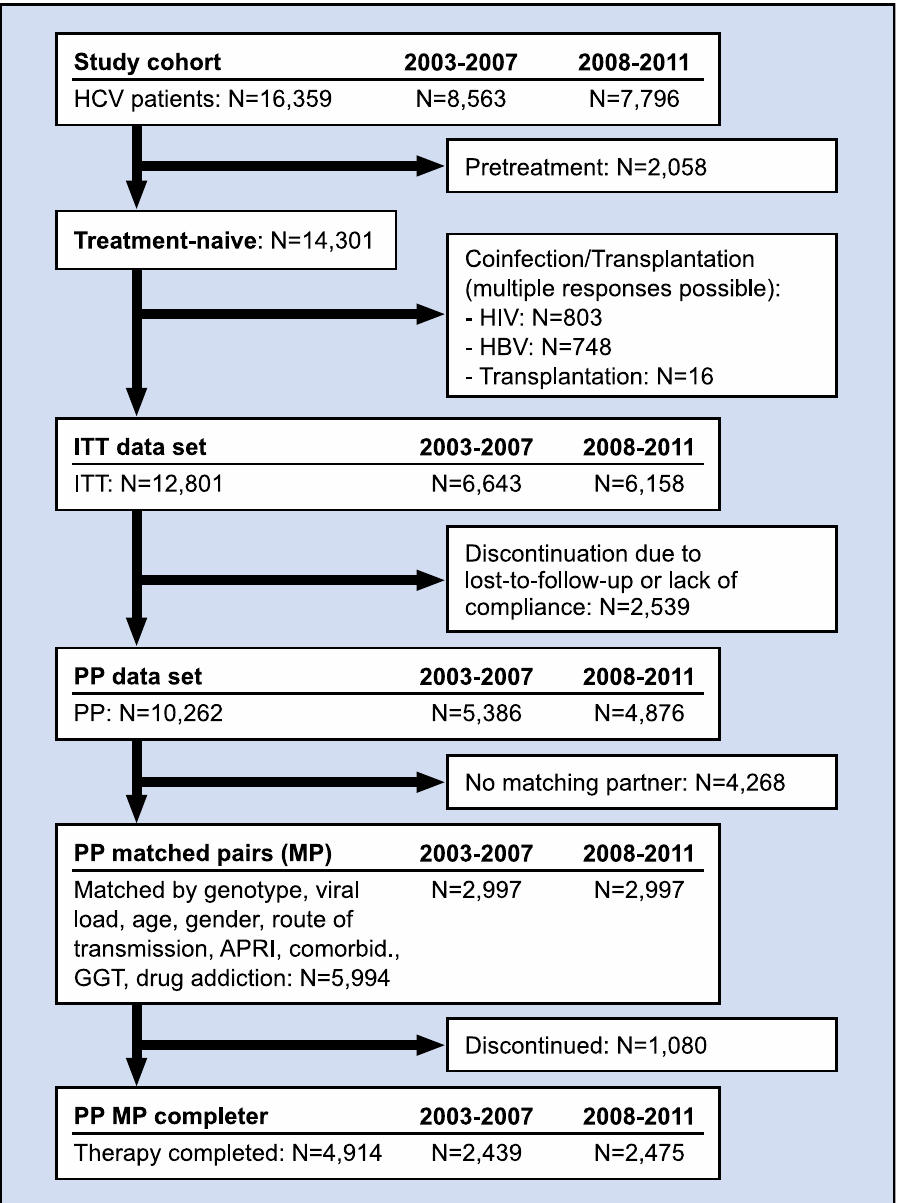
Fig 1. Patient disposition. APRI, aspartate aminotransferase (AST) platelet ratio index; GGT, gamma- glutamyl transferase; HBV, hepatitis B virus; HIV, human immunodeficiency virus; ITT, intent to treat; MP, matched pairs; PP, per